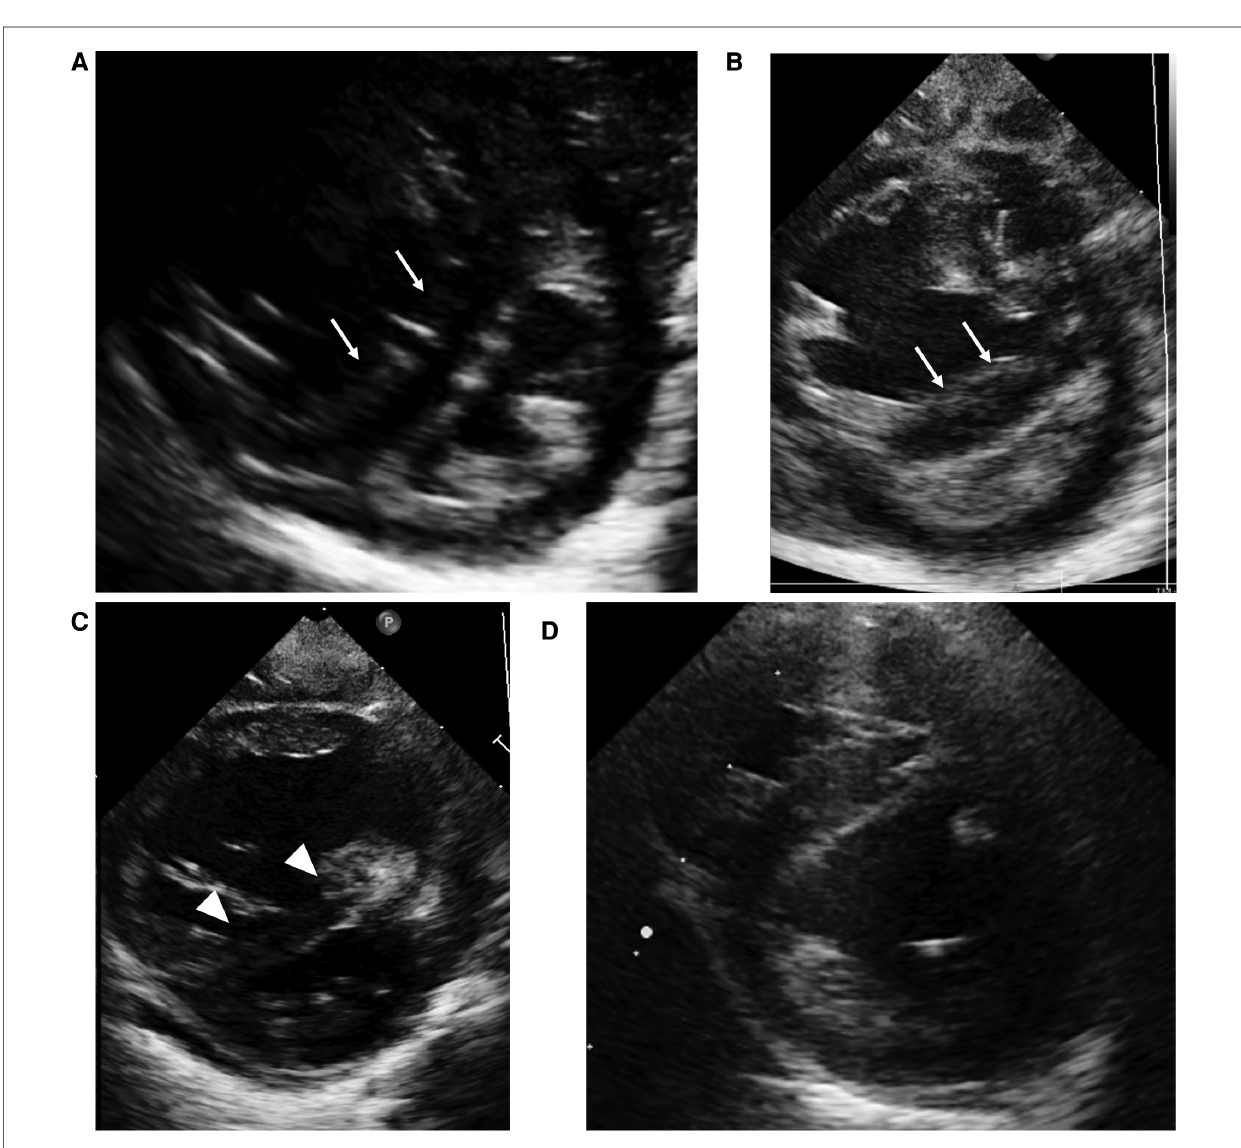
FIGURE 1 Case 1: echocardiography in the parasternal short axis view. Echocardiography at birth ( A ) and at the time of PH crisis ( B ) showing septal bowing to the left (white arrow) and a D-shaped left ventricle that indicates over-systemic pulmonary arterial pressure. On the day after the initiation of high-dose epoprostenol ( C ), left sided deviation of intraventricular septum (white arrowhead) ameliorated compared to at the time of PH crisis. At one year of age ( D ), the interventricular septal shift and left ventricle compression have